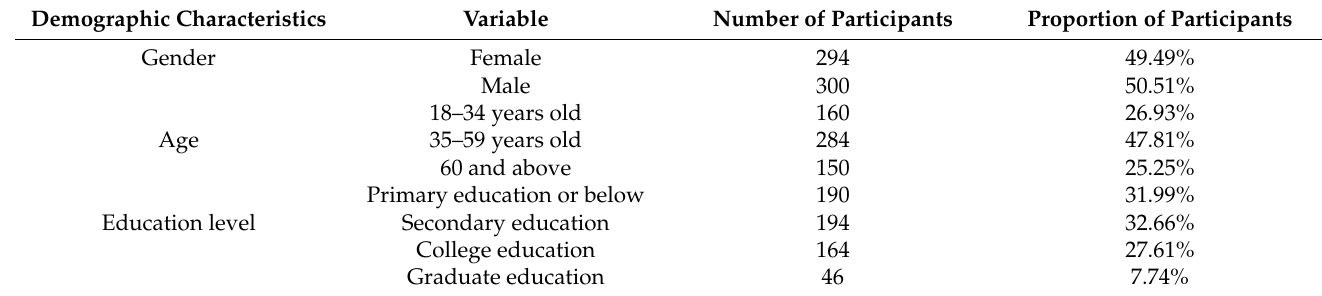
Table 6. The demographic characteristics of participants.